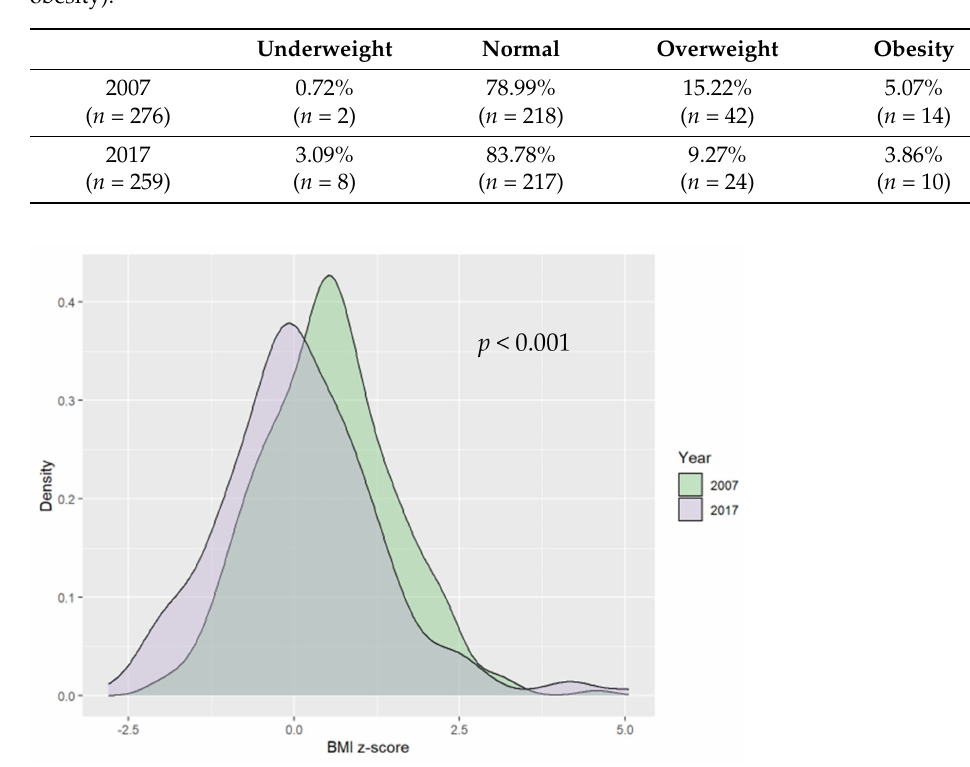
Table 1. Number of children in four weight categories (underweight, normal, overweight, and obesity).